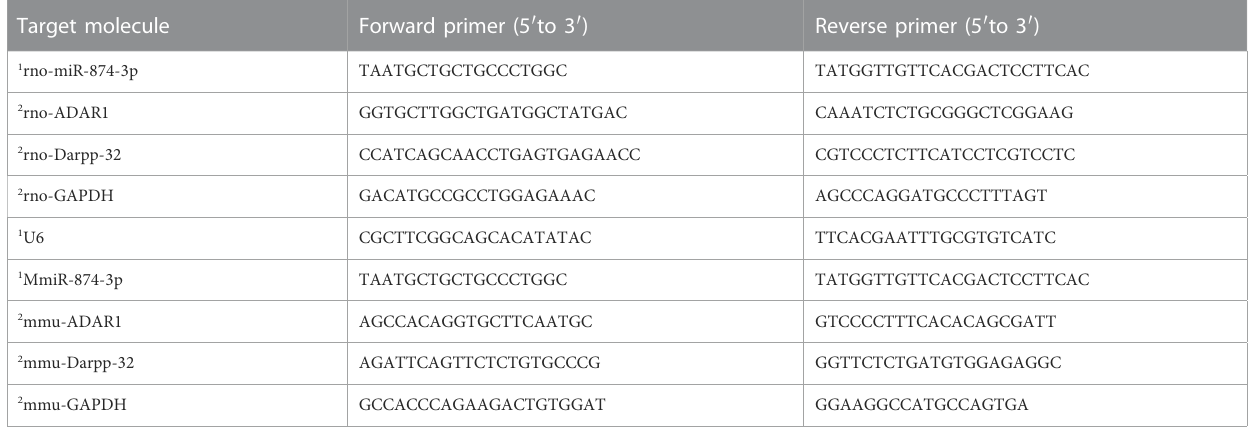
TABLE 1 Primer sequence of qRT-PCR. Target